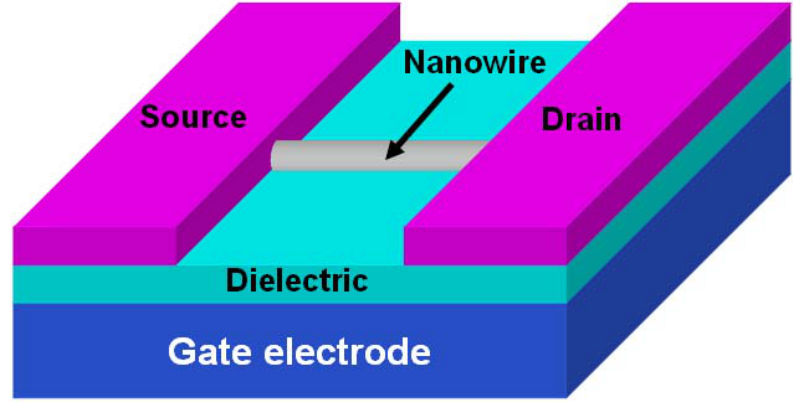
Figure 2. The schematic of the single nanowire field effect